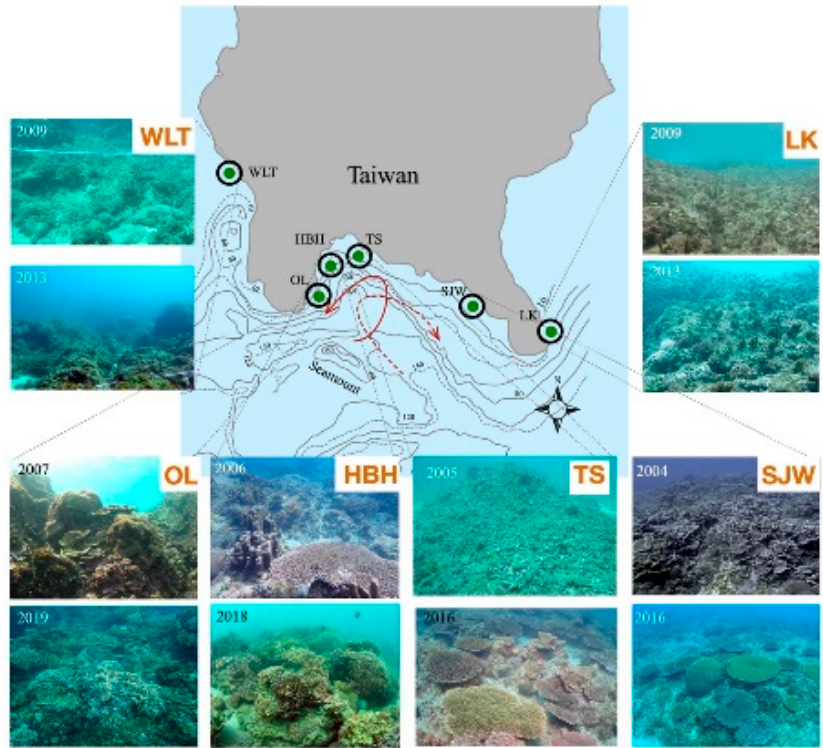
Figure 2. Depth contours in Nanwan, Kenting National Park, and coral communities at six sites and two time points, showing the status of coral communities through time. The sites include Wanlitung (WLT) on the west coast of Hengchun Peninsula, NPP Outlet (OL) and Houbihu (HBH) on the west coast of Nanwan, Tiaoshi (TS) and Siangjiaowan (SJW) on the east coast of Nanwan, and Longkeng (LK) on the east coast of Hengchun Peninsula. The solid and dotted arrow line indicates the direction of tidal flow patterns in flows and eddies. Depth contour figure was adapted from Lee, H.-J. etc.1999a.